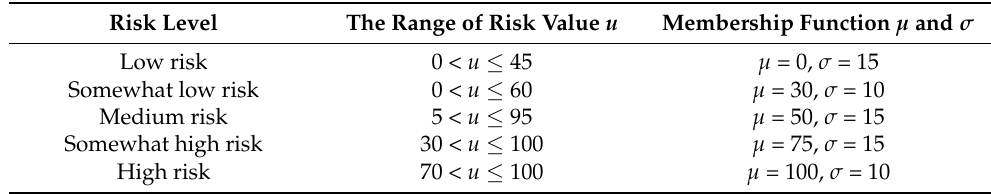
Table 9. Value at risk and membership